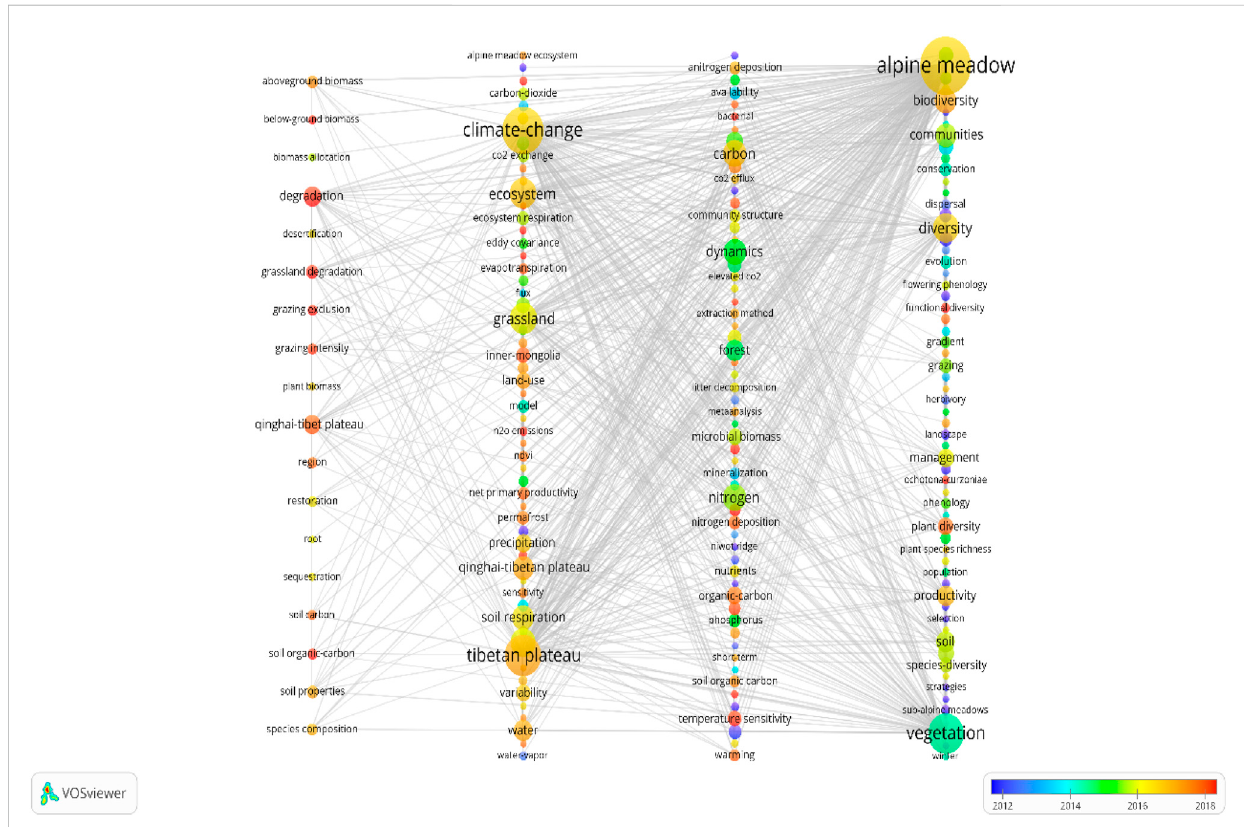
FIGURE 9 Temporal overlapping co-occurrence clustering of keywords in alpine meadow research